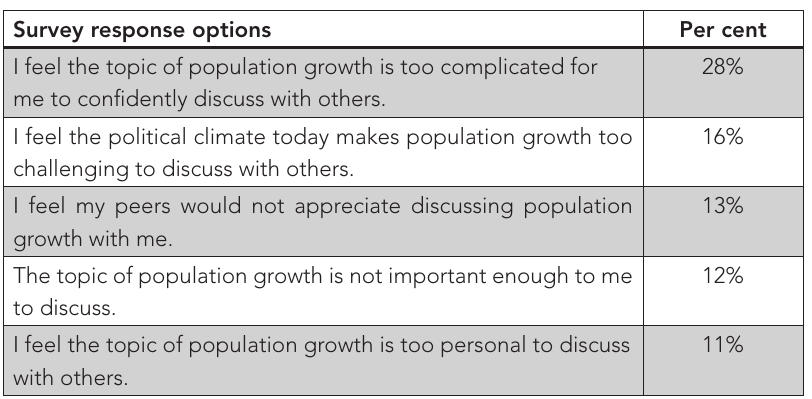
Table 2: Rationale for not wanting to discuss population growth with others Survey response